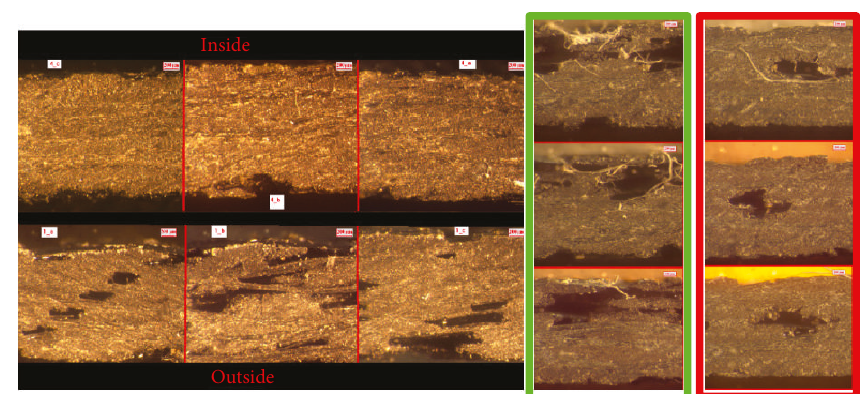
Figure 5: Inspection with an optical microscope.